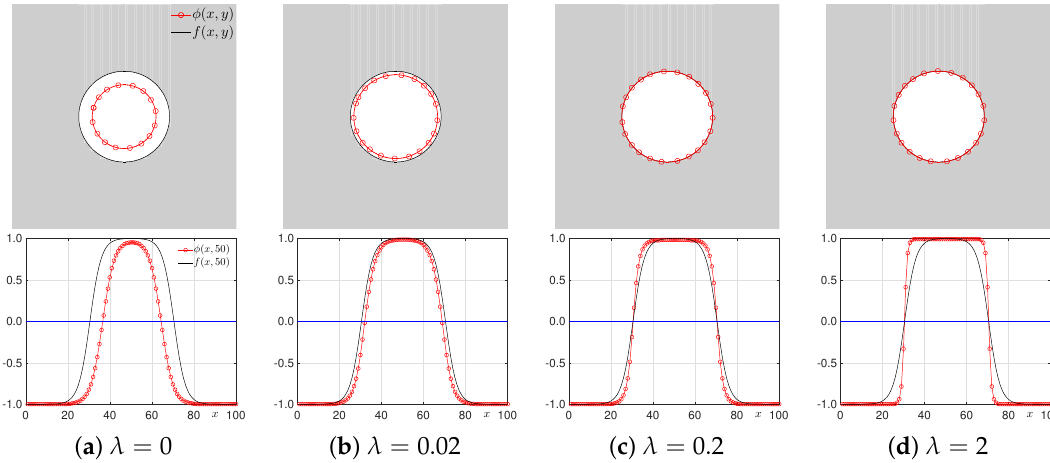
Figure 4. Zero level set (top row) and cross section (bottom row) along the y = 50 of given image f (solid line) and numerical solution φ (circle-marked line) for different λ